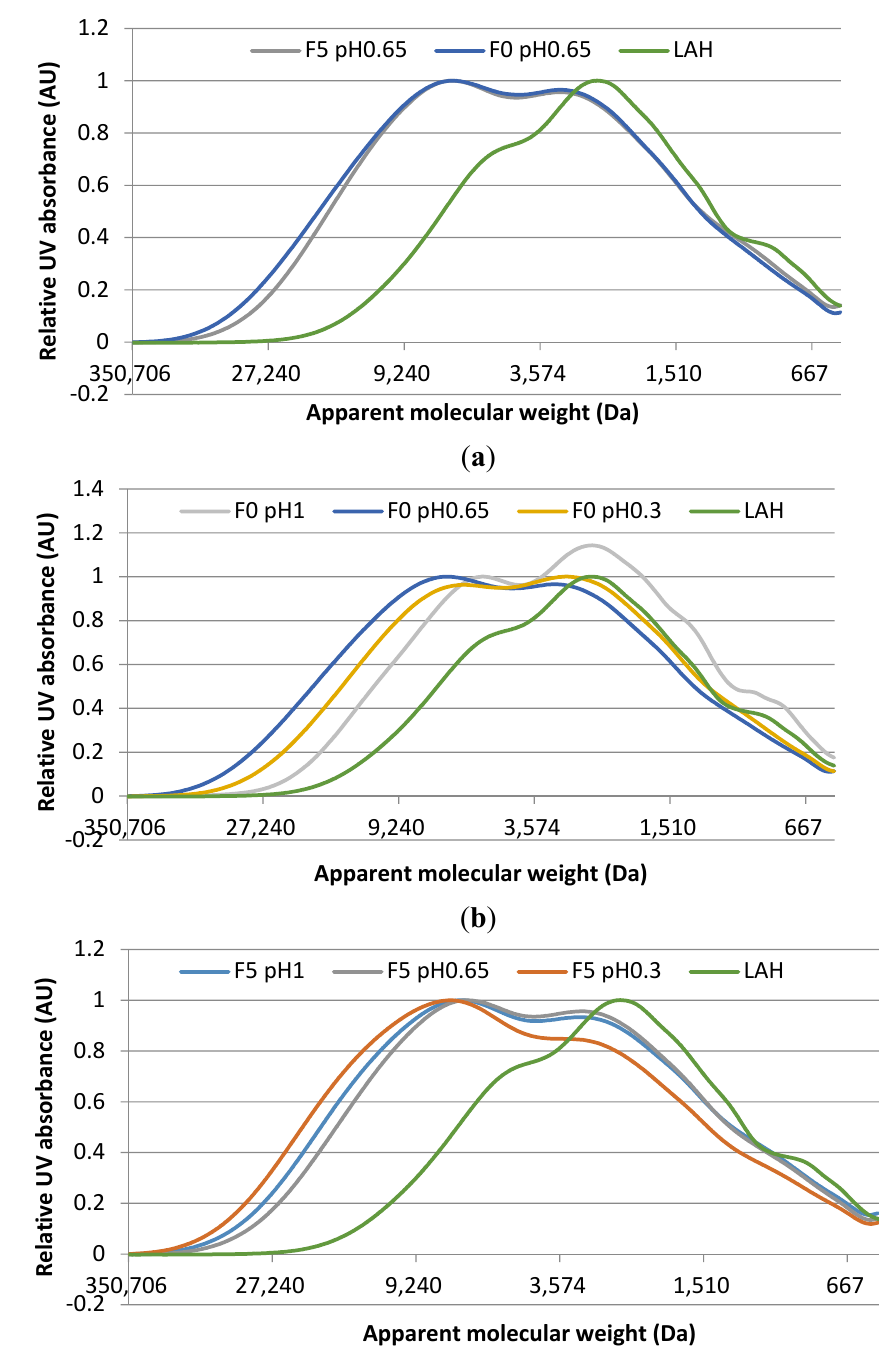
Figure 3. Normalized molecular weight distribution of some of the prepared adhesive blends compared to untreated lignin (LAH): ( a ) molecular weight distribution of blends prepared at pH = 0.65 with 5% and 0% furfural (F5_065 and F0_065); ( b ) molecular weight distribution of adhesive blends with 0% furfural at pH conditions 0.3, 0.65, and 1 (F0_03, F0_065, and F0_1); and ( c ) molecular weight distribution of adhesive blends with 5% furfural at pH conditions 0.3, 0.65 and 1 (F5_03, F5_065 and